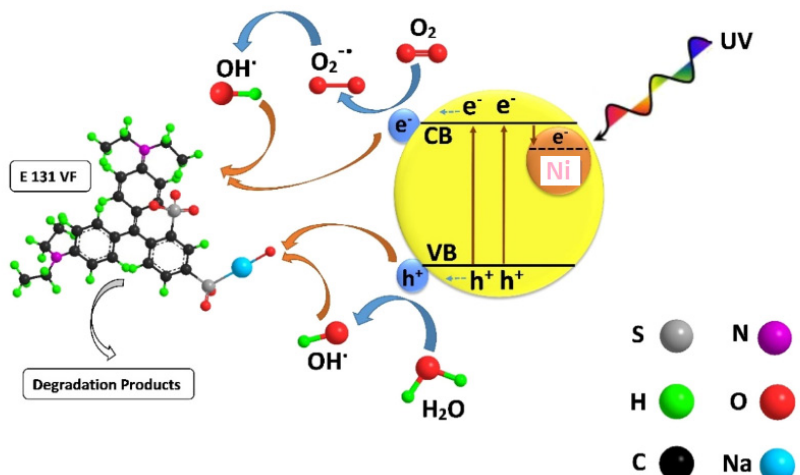
Fig. 14. Proposed mechanism for photocatalytic degradation of E 131 VF dye by Ni-doped TiO